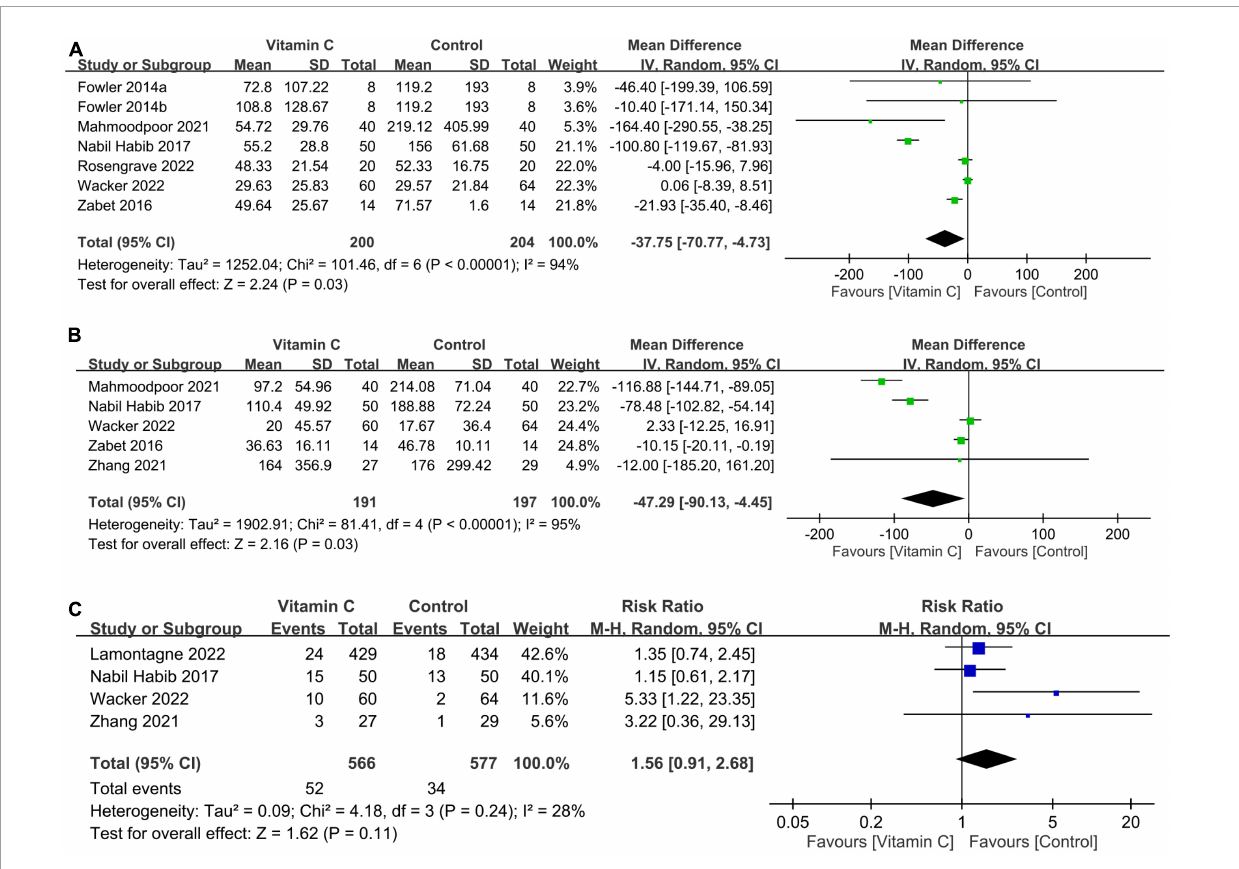
FIGURE6 Forest plot comparing (A) duration of vasopressor use; (B) mechanical ventilation time; and (C) risk of renal replacement therapy between the intravenous vitamin C and control groups. CI, confidence interval; IV, inverse variance; M-H,